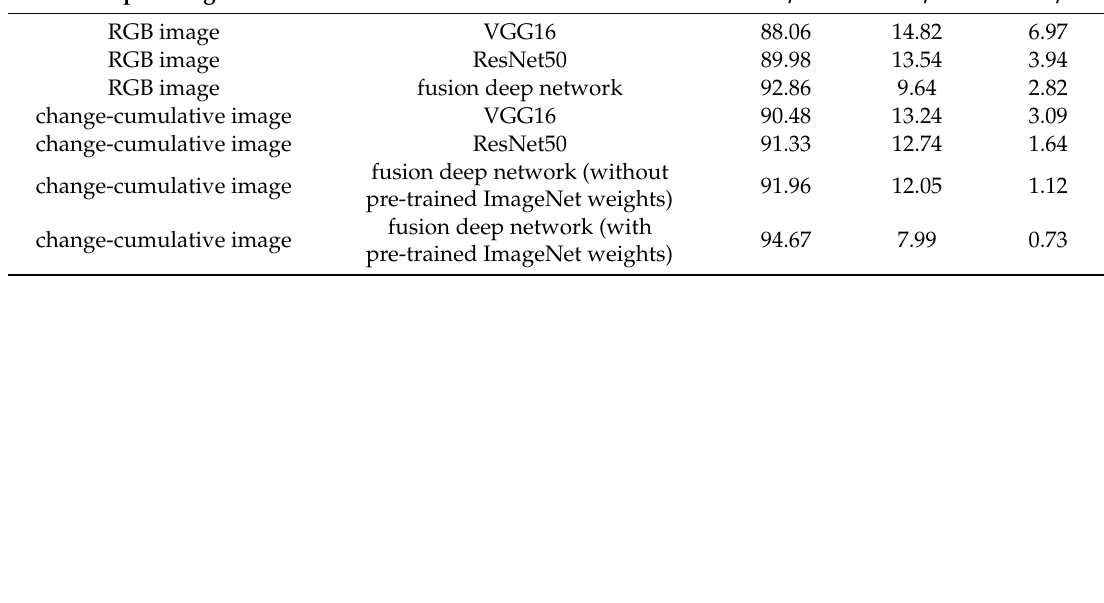
Table 4. Comparisons with different input images and network models.